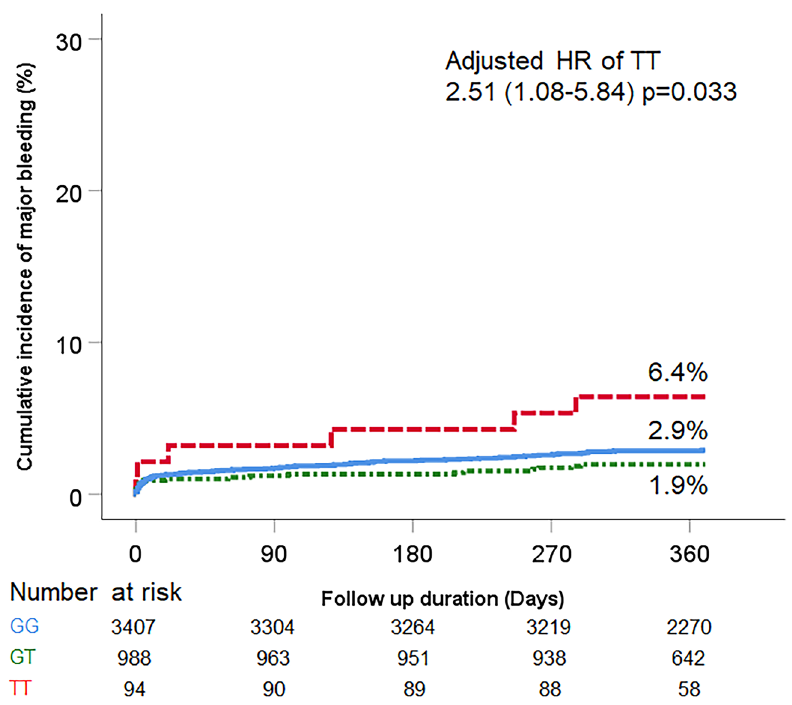
Figure 1. Time-to-event curves through 1 year for major bleeding according to the P2Y12 G52T